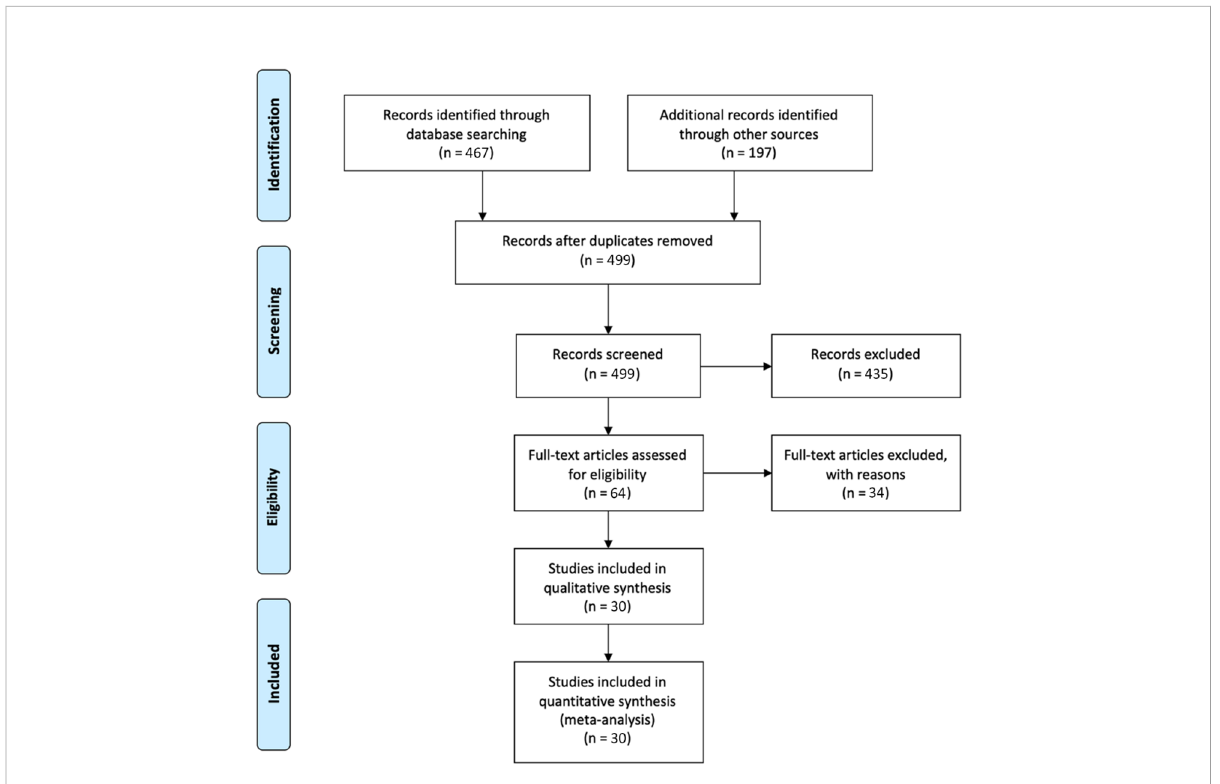
FIGURE 1 PRISMA fl ow diagram of study